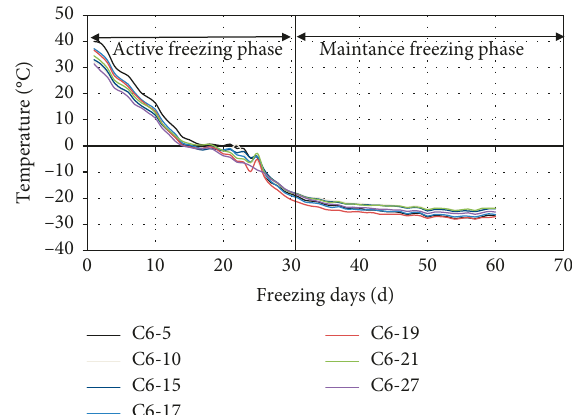
Figure 13: Curves of temperature and times at C6 temperature measuring hole.